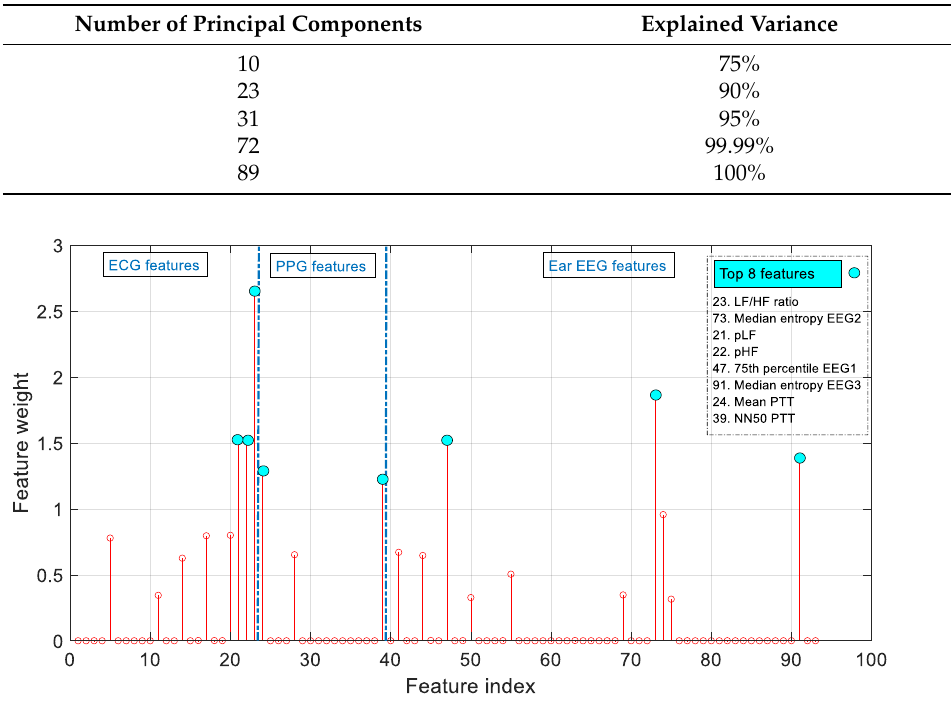
Figure 8. Feature weights as a result of the Neighborhood Component Analysis (NCA).